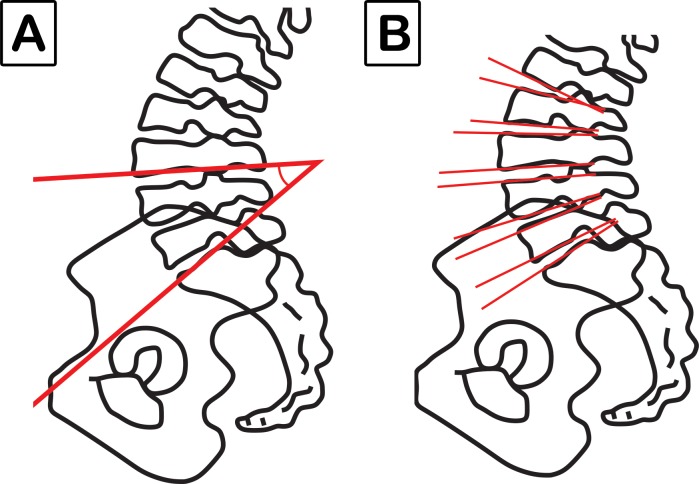
A) Lumbar lordosis angle measured by L3 inferior endplate to sacral endplate (L3-S1). B) Lumbar intervertebral angles: L3-L4, L4-L5, and L5-S1.